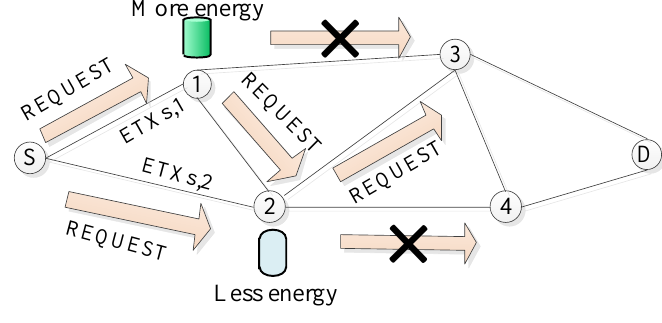
Figure 14. EEPR algorithm.